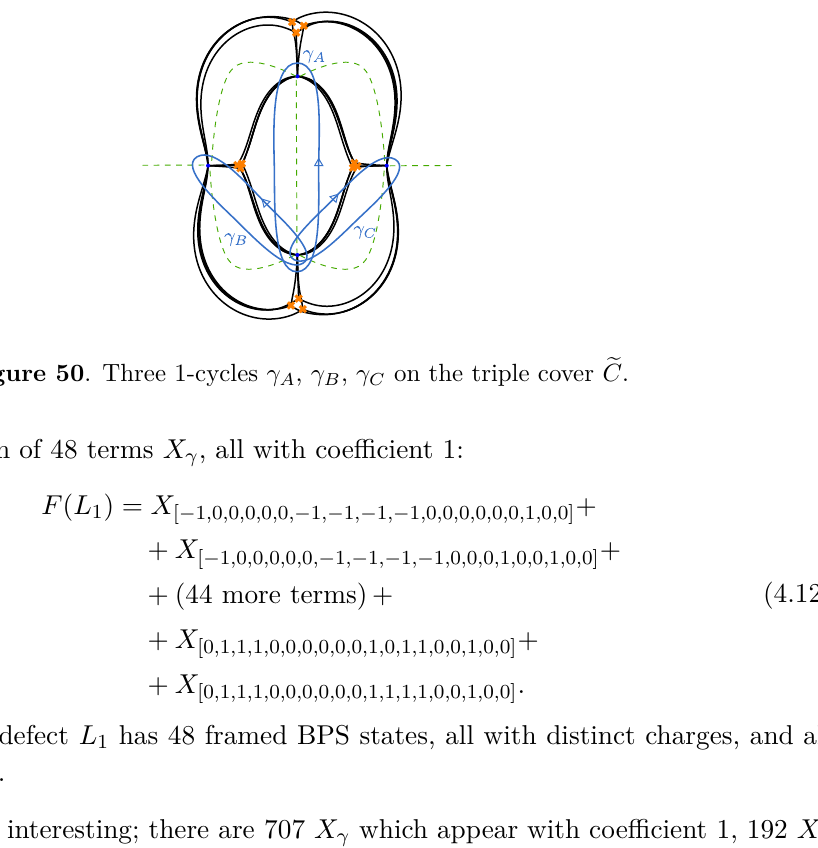
Figure 49 . The WKB triangulation associated to the spectral networks shown in figure 48, with the 3 edges and 2 triangles numbered, and an auxiliary choice of orientation fixed on each edge.